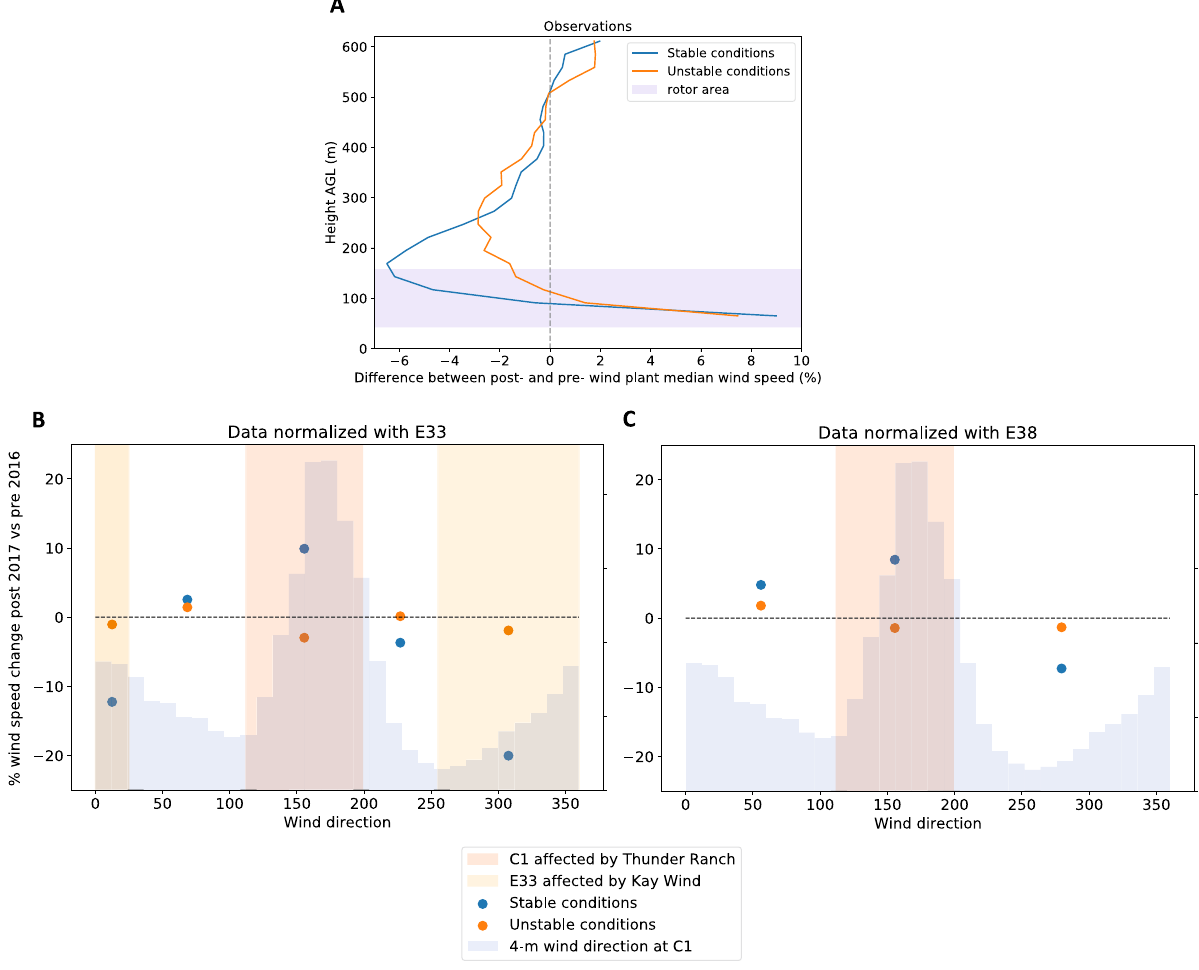
Figure 4. ( A ) Median wind speed percentage deficit between post- and pre-wind plant periods calculated from the lidar observations at C1 for stable and unstable conditions. The blue shaded area shows the vertical limits of the turbine rotor disks (which have been corrected for the < 10 -m terrain elevation difference between the lidar location and the Thunder Ranch wind plant). ( B , C ) Median percentage change in 4-m wind speed when comparing post- and pre-wind plant observations as a function of wind direction. Data at C1 are normalized according to Eq. (2) using observations at E33 ( B ) and E38 ( C ). In each panel, the background blue shading indicates the wind direction